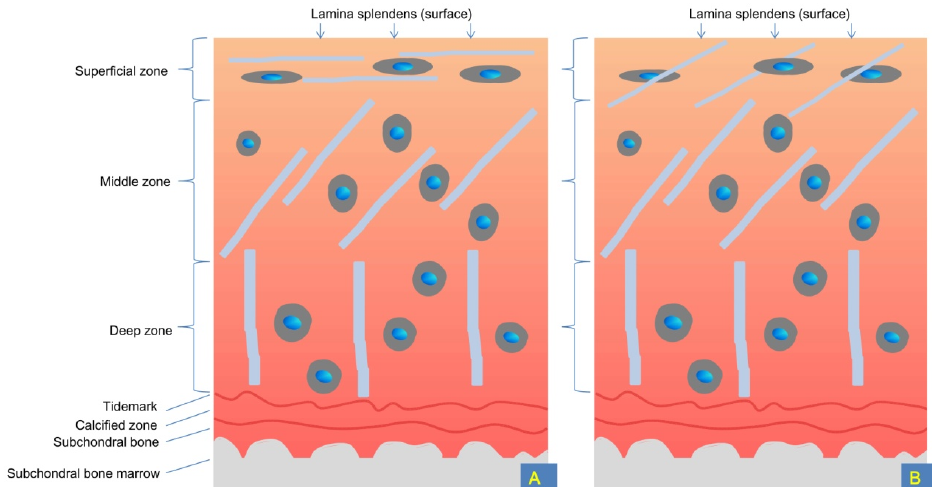
Figure 1. Schematic demonstration of different layers of articular (hyaline) cartilage and subchondral bone of human knee joint. Arrows indicate the outermost layer of articular (hyaline) cartilage, that is, the lamina splendens. In some literature, the lamina splendens is also referred to as “the surface zone.” The superficial zone contains thin collagen fibrils and the middle zone contains thin and thick collagen fibrils; the deep zone contains thick collagen fibrils and is, therefore, the most stress ‐ resistant. ( A ). Traditional concepts suggest that the superficial/gliding zone contains collagen fibrils parallel to the surface of healthy hyaline cartilage (whereas the lamina splendens does not contain collagen fibrils and chondrocytes); ( B ). Current findings indicate that the superficial/gliding zone contains collagen fibrils oblique to the surface of healthy hyaline cartilage (and the lamina splendens contain interwoven collagen bundles, which are not shown in this figure). Notably, interwoven collagen bundles within the lamina splendens rarely integrate obliquely oriented collagen fibrils in the superficial zone, which implies no tight connection between the two layers. Such a feature provides limited resistance to tearing/peeling off this surface layer from underlying cartilage tissues during exercise/sports accidents.